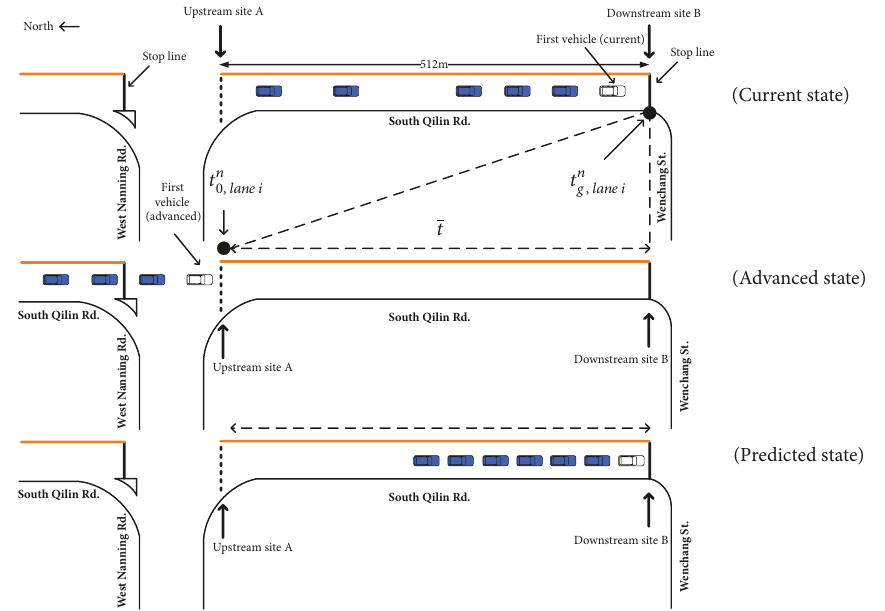
Figure 2: The initial state for queue length